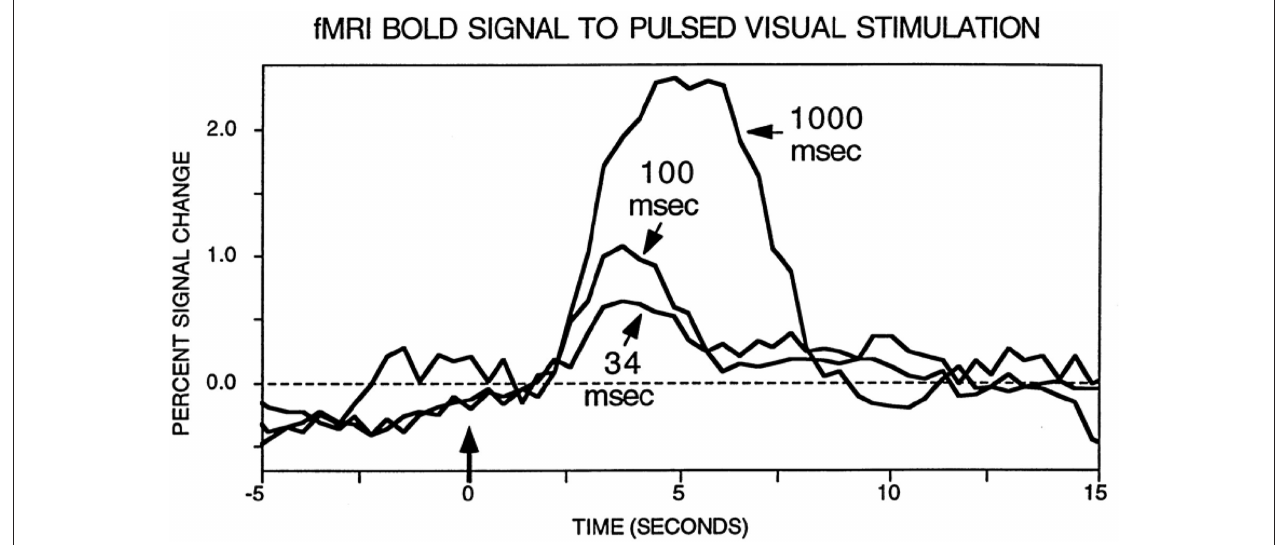
Figure 1 | fMri responses to brief stimuli. Original results by Savoy et al. (1995) illustrating the fact that a clear signal change is observed for very brief events. Data from Savoy et al. (1995). Figure reproduced from (Rosen et al., 1998).